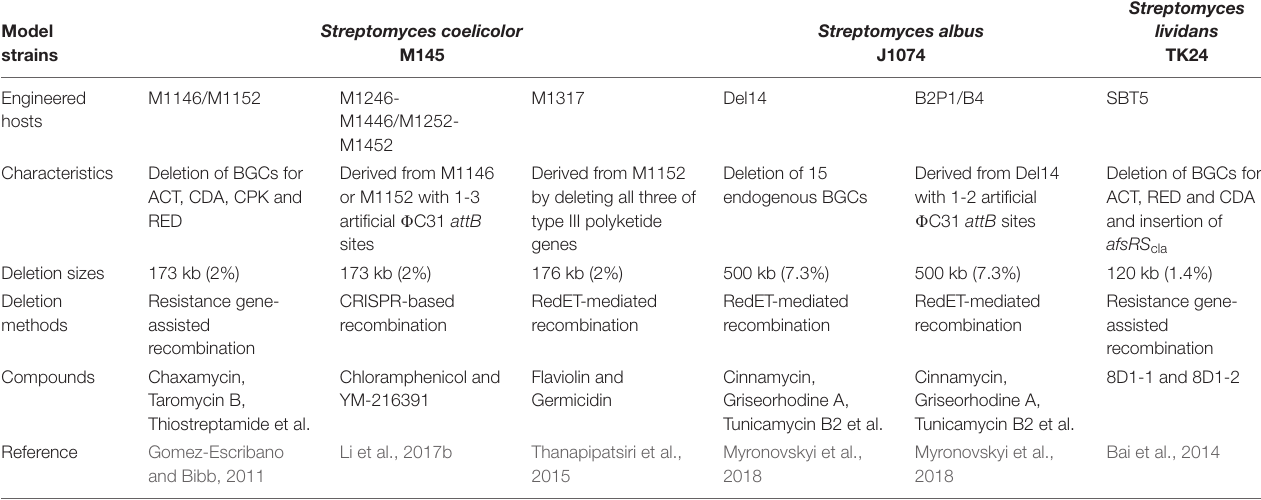
TABLE 1 | Characteristics of synthetic model Streptomyces